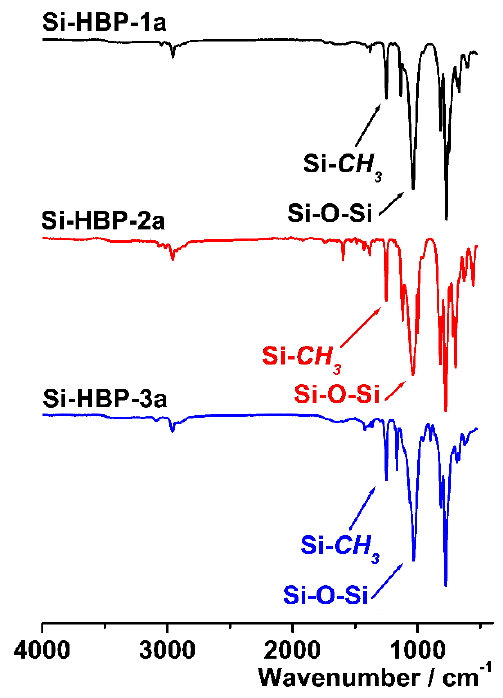
Figure 1. Fourier transform infrared ( FT-IR) spectroscopy of Si-HBP-1a, Si-HBP-2a and Si-HBP-3a.